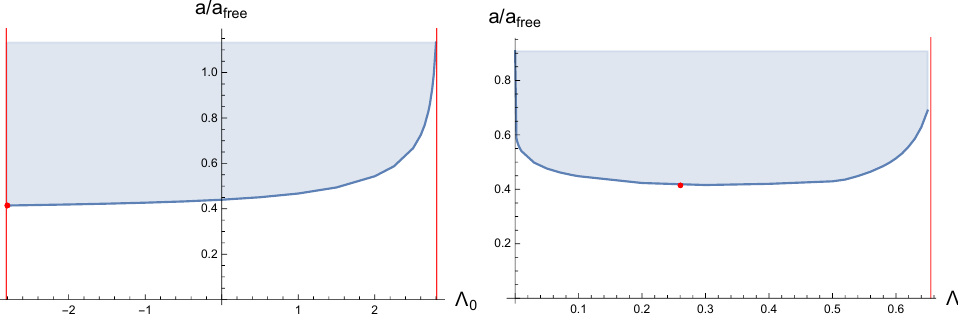
Figure 3 . Minimum of the a -anomaly of the UV CFT as a function of the parameters Λ 0 and Λ 2 defined in (1.4). The red dot marks the absolute minimum. The red vertical lines indicate the boundaries of the allowed regions for Λ 0 and Λ 2